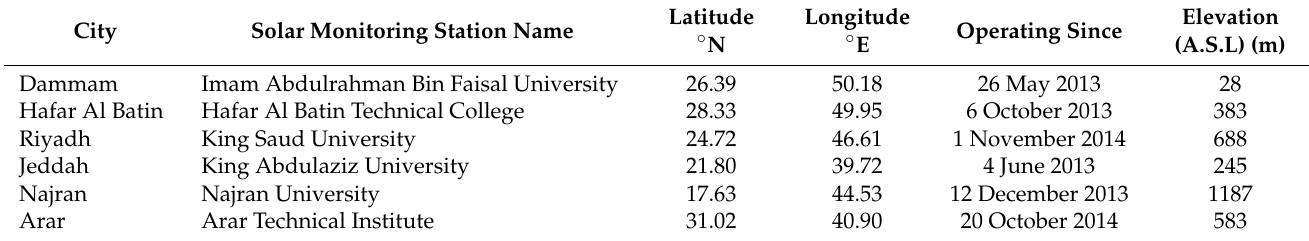
Table 2. Specifications of solar monitoring stations used in this study, covering the period 2013 − 2021 (9